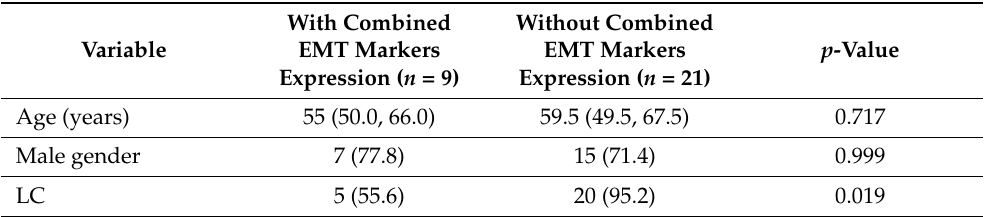
Table 2. Comparison of clinicopathological data between HCC patients with combined EMT markers expression and HCC patients without combined EMT markers